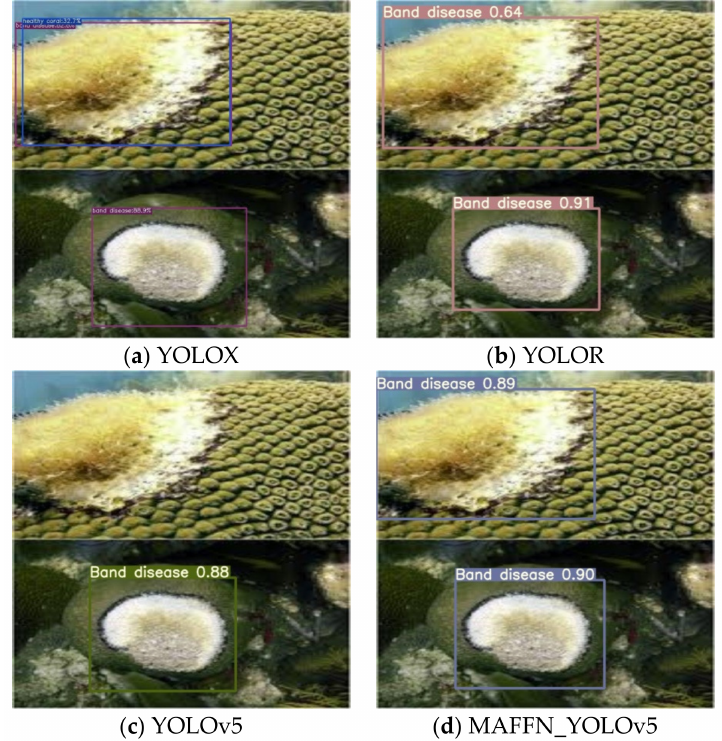
Figure 25. Band disease